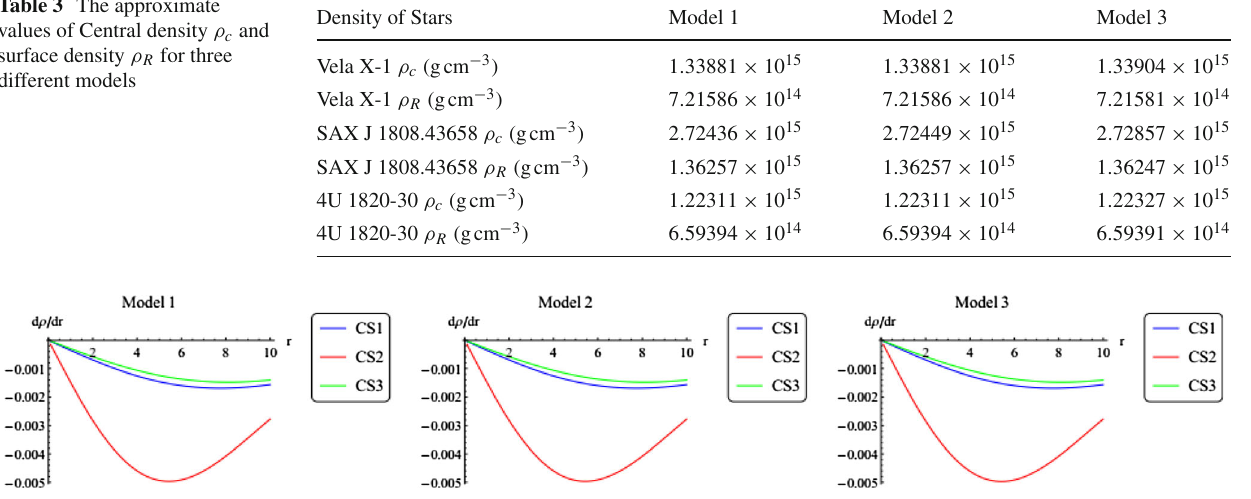
Fig. 4 Evolution of d ρ/ dr for charged stars, Vela X-1, SAX J 1808.4-3658, and 4U 1820-30, under different viable f ( G ) models